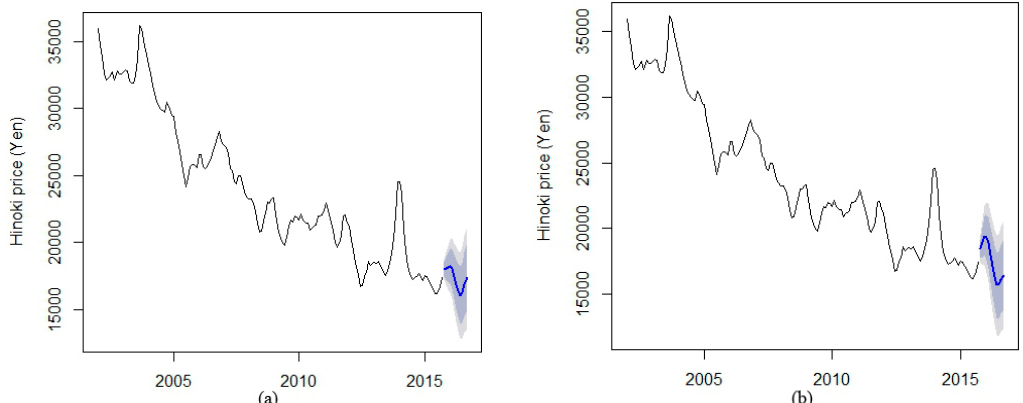
Figure 6. Forecasts of the hinoki log prices: ( a ) Point forecasts and forecast intervals at 80% and 95% levels by ETS; ( b ) point forecasts and forecast intervals at 80% and 95% levels by ARIMA.